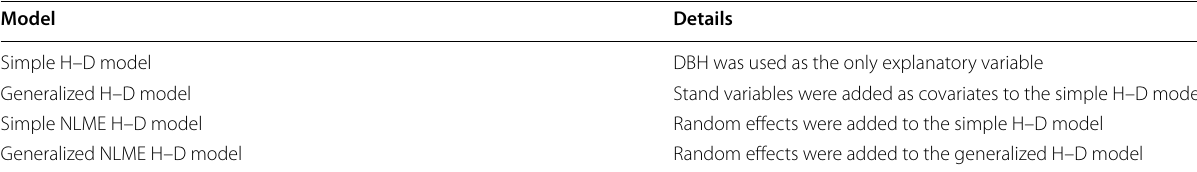
Table 2 Overview of common and more advanced tree height models developed